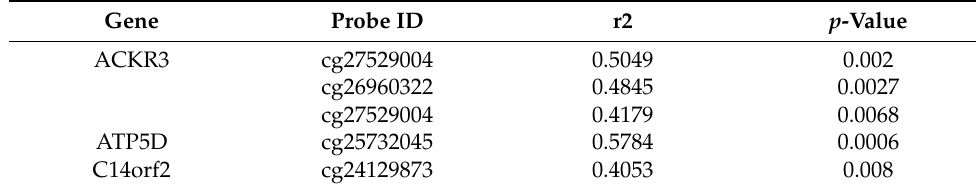
Figure 6. Validation of DEG/DMC for arterial-venous and umbilical/placental identity. ( A ) Schematic proportional representation of probes laying micro- and macro-vascular genes. Proportions are represented by no correlated and no DMP genes (black dots), no correlated but DMP genes (gray dots), correlated but no DMP genes (red dots), and correlated and DMP genes (red dots). ( B ) Graph bars show six probes ID with high predictive power differentiating microvascular endothelial cells tested by Lasso regression analysis and validated by logistic regression ( C ). ( D ) Schematic proportional representation of probes laying arterio-venous genes. Proportions are represented by no correlated and no DMP genes (black dots), no correlated but DMP genes (gray dots), correlated but no DMP genes (red dots), and correlated and DMP genes (red dots). ( E ) Graph bars show nine probes ID with high predictive power differentiating arterio-venous nature of endothelial cells tested by Lasso regression analysis and validated by logistic regression ( F ). Table 1. Infinium probes with high DNA methylation/transcript level correlation among microvas- cular